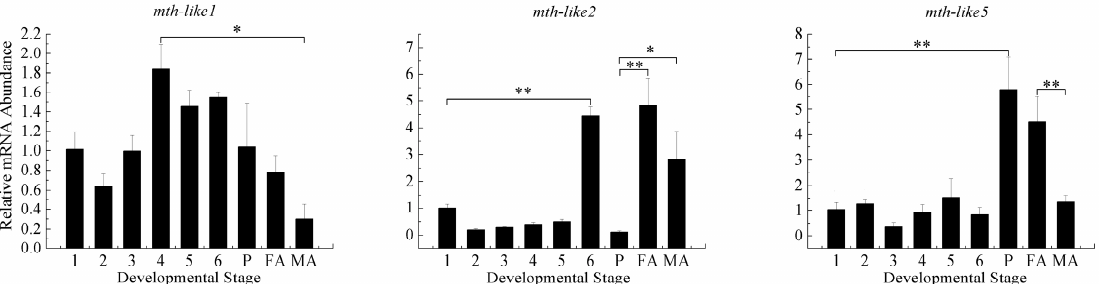
Figure 3. Developmental expression levels of mth-like genes. The relative expression indicates the level of each mth-like transcript normalized to the internal standard of EF-1 α , compared to expression levels of the first instar. Data are shown as the mean ± SD. Asterisks indicate differences that are statistically significant (*, p < 0.05; **, p < 0.01). 1–6, 1st–6th instar larvae; P, pupae; FA, female adults; MA, male adults.